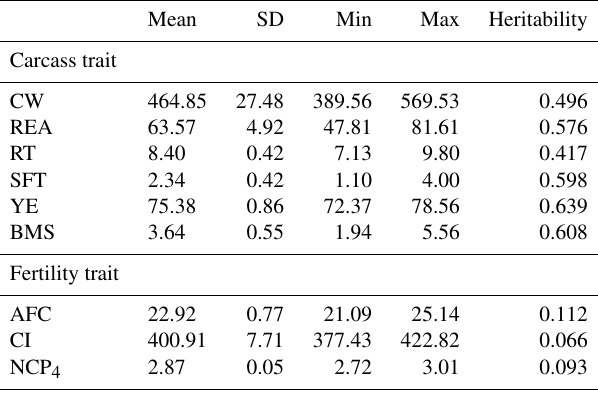
Table 1. Summary statistics of predicted breeding values and heri- tabilities for carcass and fertility traits in the Japanese Black cattle population ( n =